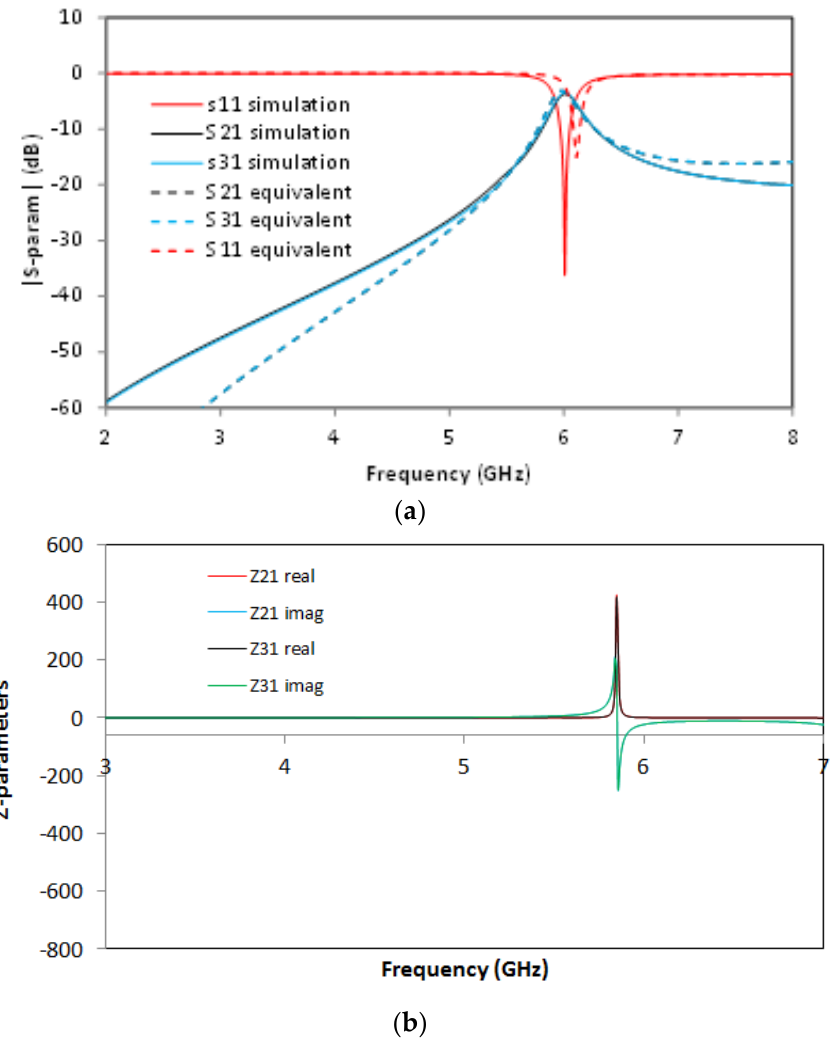
Figure 10. ( a ) Simulated S11 (solid red line), simulated S11 for the equivalent circuit model (dashed red line), simulated S21 (solid black line), simulated S21 for the equivalent circuit model (dashed black line), simulated S31 (solid blue line), simulated S31 for the equivalent circuit model (dashed blue line). ( b ) Impedance graph: Z21 real part (solid red line), Z21 imaginary part (solid blue line), Z31 real part (solid black line), Z31 imaginary part (solid green line).